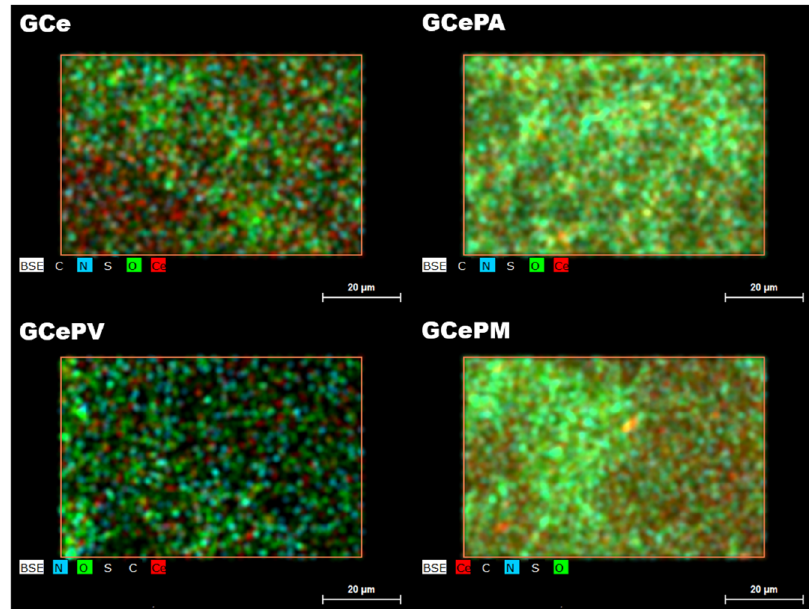
Figure 8. EDX mapping of all composite monoliths for C, Ce, O, N, and S. It can be seen (Figure 8 and Table 2) that the percentages of the elements changed when the particles with polymer brushes were added to the rGO monolith. The percentage of Ce was in the range of 3.7–6.7%. For the case of S, a small percentage was also detected (0.1–0.7%). The S was found due to synthetic reasons, namely the polymer brushes with the CTA agent grafted on the particles. A slight increase in N was also found for the samples that had N in their molecular formulas (samples with PNVCL and PMETAC). Most important was the increase in the O content, since all polymers had extra O atoms in their structures (PAA had two, PNVCL had one, and PMETAC had two). Therefore, 11.2% of the O at the initial monolith with CeO 2 was almost tripled for the GCePA sample (31.8%) and doubled for the GCePM sample (21.7%), and it was also relatively higher in the GCePN sample (17.0%). This could also be verified by mapping these monoliths (Figure 8), where the GCePA and GCePM samples showed a greener color (the one attributed to O) in the mappings. 3.2.2. TGA TGA was used for the thermal characterization of the monolithic materials, as can be seen in Figure 9.